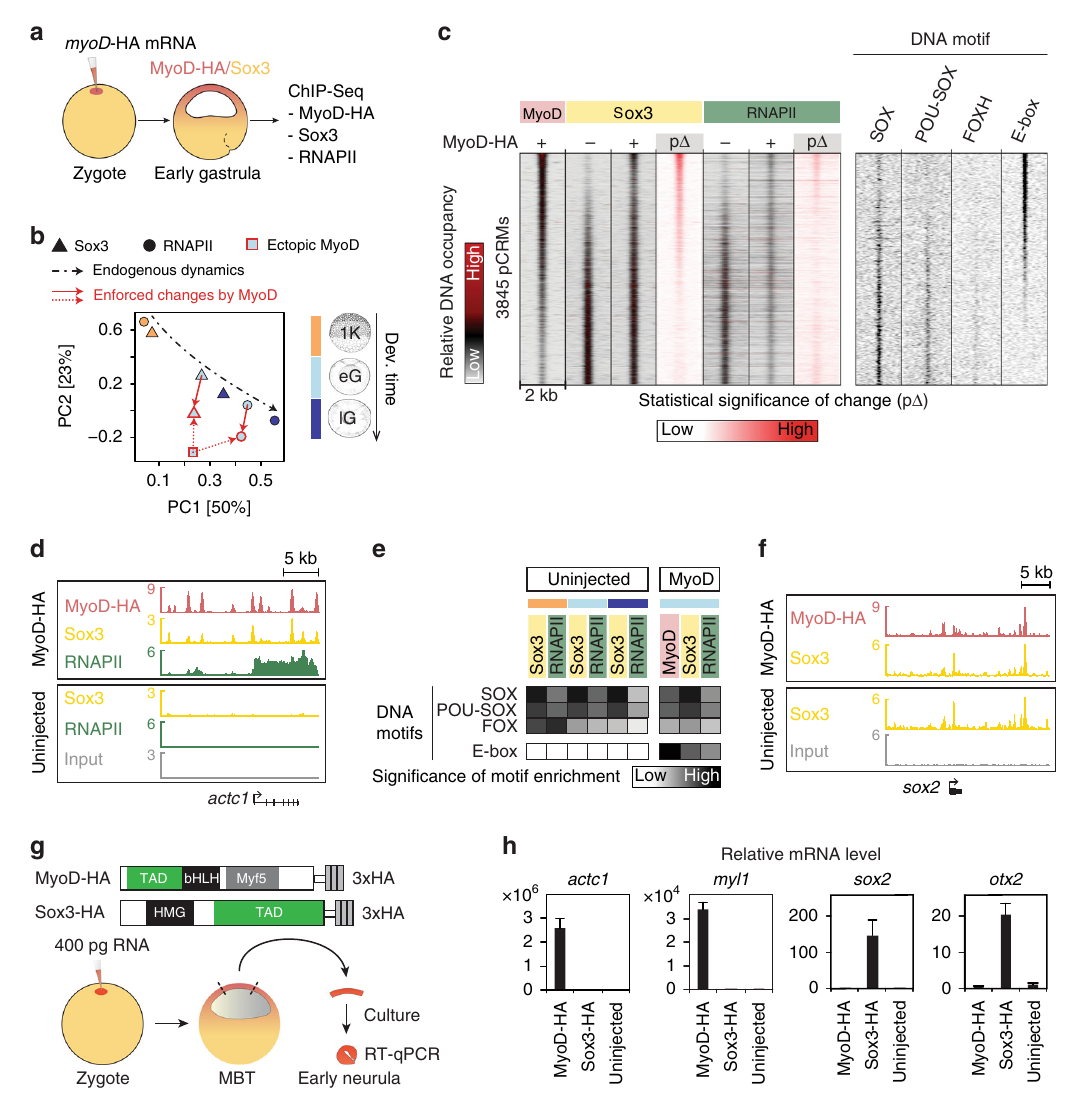
Fig. 4 Ectopic expression of the muscle determinant MyoD reveals the effect of co-expressed TFs on chromatin engagement and gene expression. a Experimental design: Ectopic expression of the MyoD-HA mRNA construct injected into the animal hemisphere followed by the genome-wide chromatin pro fi ling (ChIP-Seq; n = 2 biologically independent samples) of MyoD-HA, Sox3 and RNAPII in early gastrula embryos. b Biplot of principal component (PC) 1 (accounting for 50% variance) and 2 (23% variance) shows the relationship of Sox3 (triangle), RNAPII (circle) and MyoD-HA (square) binding levels across MyoD + and/or Sox3 + pCRMs. Arrows show the normal temporal dynamics of Sox3 and RNAPII binding (black dash-dotted line) and the MyoD-enforced (red dotted line) changes to them (red solid line) at early gastrula stage. Fill colour of symbols represents the developmental stage as indicated, while line colours refer to whether MyoD-HA was expressed (red) or not (black). Abbreviations used for the developmental timeline: 1K, 1024-cell stage; eG and lG, early and late gastrula stage. c Heat map of the DNA occupancies of 3845 pCRMs and enriched DNA motifs sorted by the signi fi cance of MyoD-HA-enforced changes (p Δ ) to Sox3 binding levels. d , f Snapshot of chromatin co-recruitment to the super-enhancers of canonical MyoD and Sox3 target genes actc1 ( d ) and sox2 ( f ), respectively. e Heat map shows the signi fi cance of DNA motif enrichments ( y -axis) at 10,000 pCRMs most frequently occupied by the indicated proteins in uninjected and MyoD-HA injected embryos ( x -axis). g Experimental design: Animal cap assay to quantify MyoD- or Sox3-enforced transcription. h RT-qPCR results from the animal cap assay. Error bars, mean + s.d. ( n = 2 biologically independent axes (Fig. 7a, e). More speci fi cally, comparison with signal LOFs revealed that 268 of the 708 genes induced by Wnt, Nodal or BMP also depended on mPouV/Sox3 (Fig. 7b and Supplementary Figs. 9 and 10b). Similarly, 175 of the 239 mVegT-dependent genes, including such as foxa1 , nodal5/6 and sox17a/b , were activated in response to signalling (Supplementary Figs. 9 and 10a). Loss of mVegT and mPouV/Sox3 jointly affected 71 genes, 57 of which also depended on Wnt, Nodal or BMP signalling (Supplementary Fig. 10b).